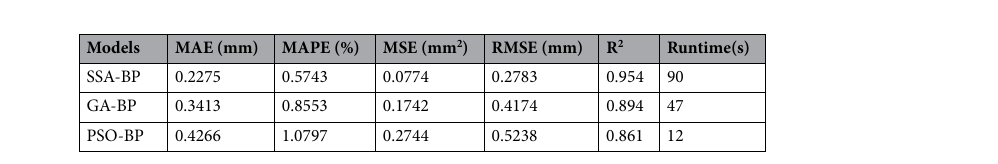
Table 13. Evaluation index value and average running time of of three models at P2.